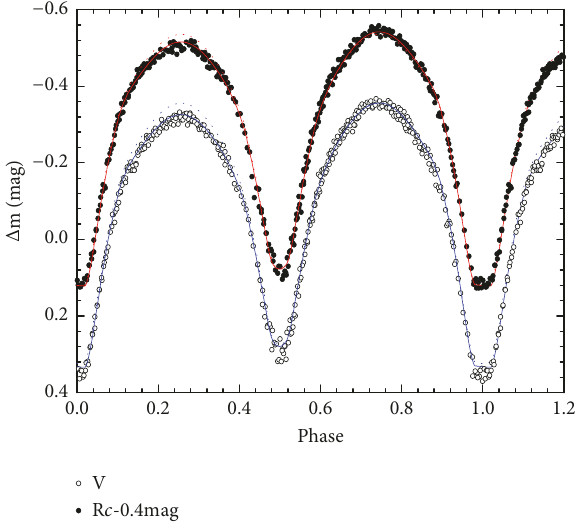
Figure 1: 𝑉𝑅 𝑐 light curves of the contact binary MT Cas, which are observed in 2013 in December by using the 85-cm telescope. The dotted and solid lines are plotted by photometric solutions without or with a dark spot,